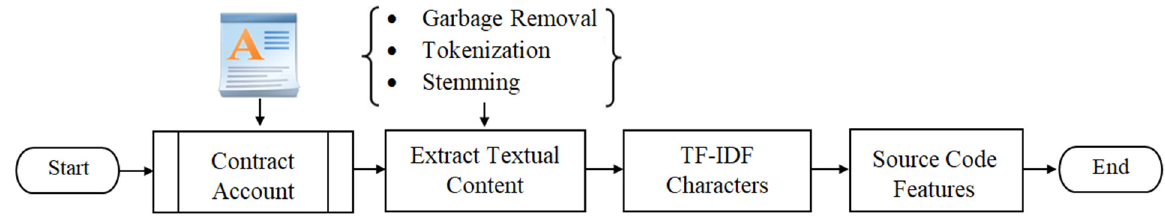
Figure 7. The process of generating source code features.